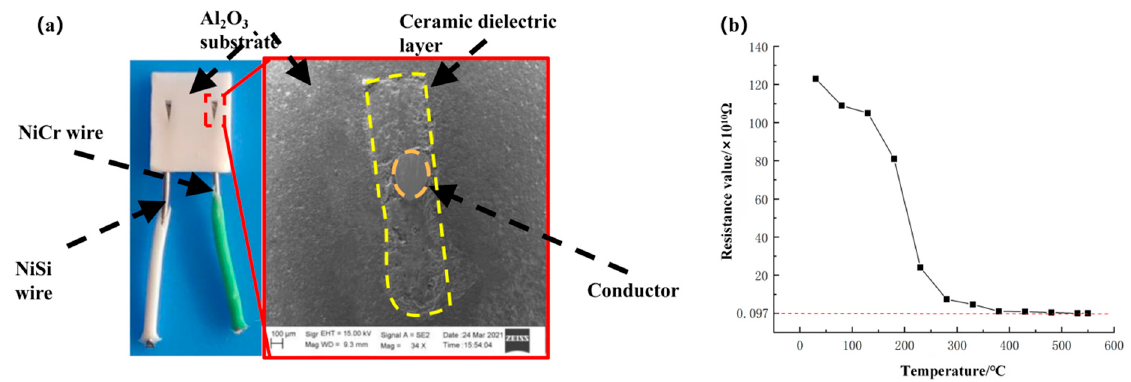
Figure 5. ( a ) SEM image of the bonding surface between the compensating conductor and ceramic substrate. ( b ) Insulation resistance curve of the compensation wire-embedded substrate.